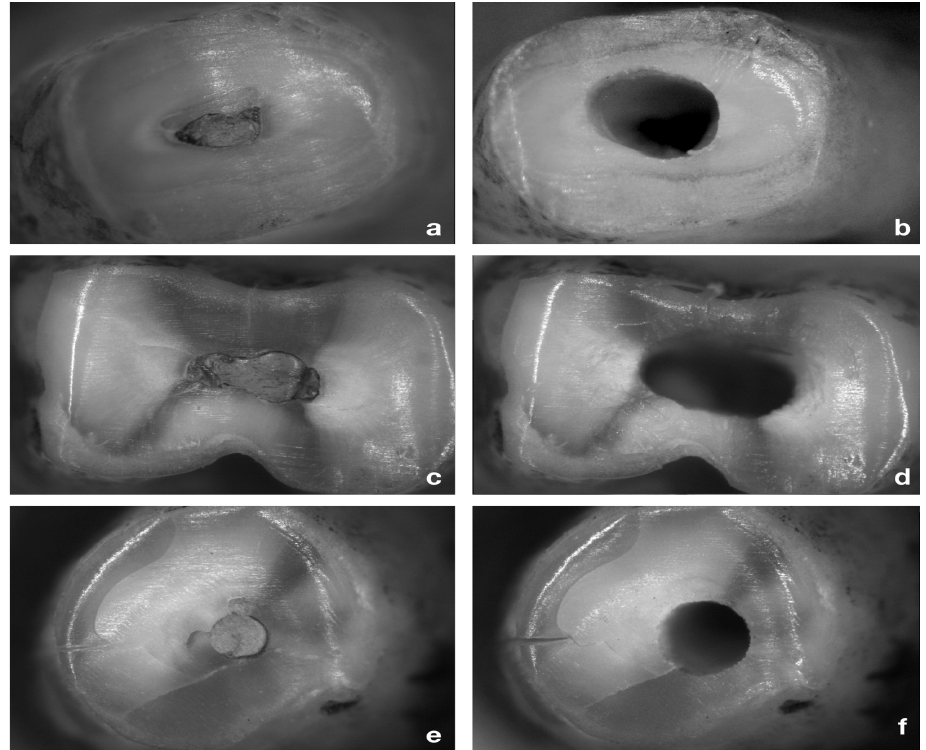
Figure 1. ( a ) Preoperative view of a single canal root; ( b ) Postoperative view of canal ( a ), absence of cracks; ( c ) Preoperative view of a mesial root; ( d ) Postoperative view of ( c ), note the precision of the preparation; ( e ) Preoperative view of a single canal root with the presence of cracks; ( f ) Postoperative view of ( e ), note the development of the